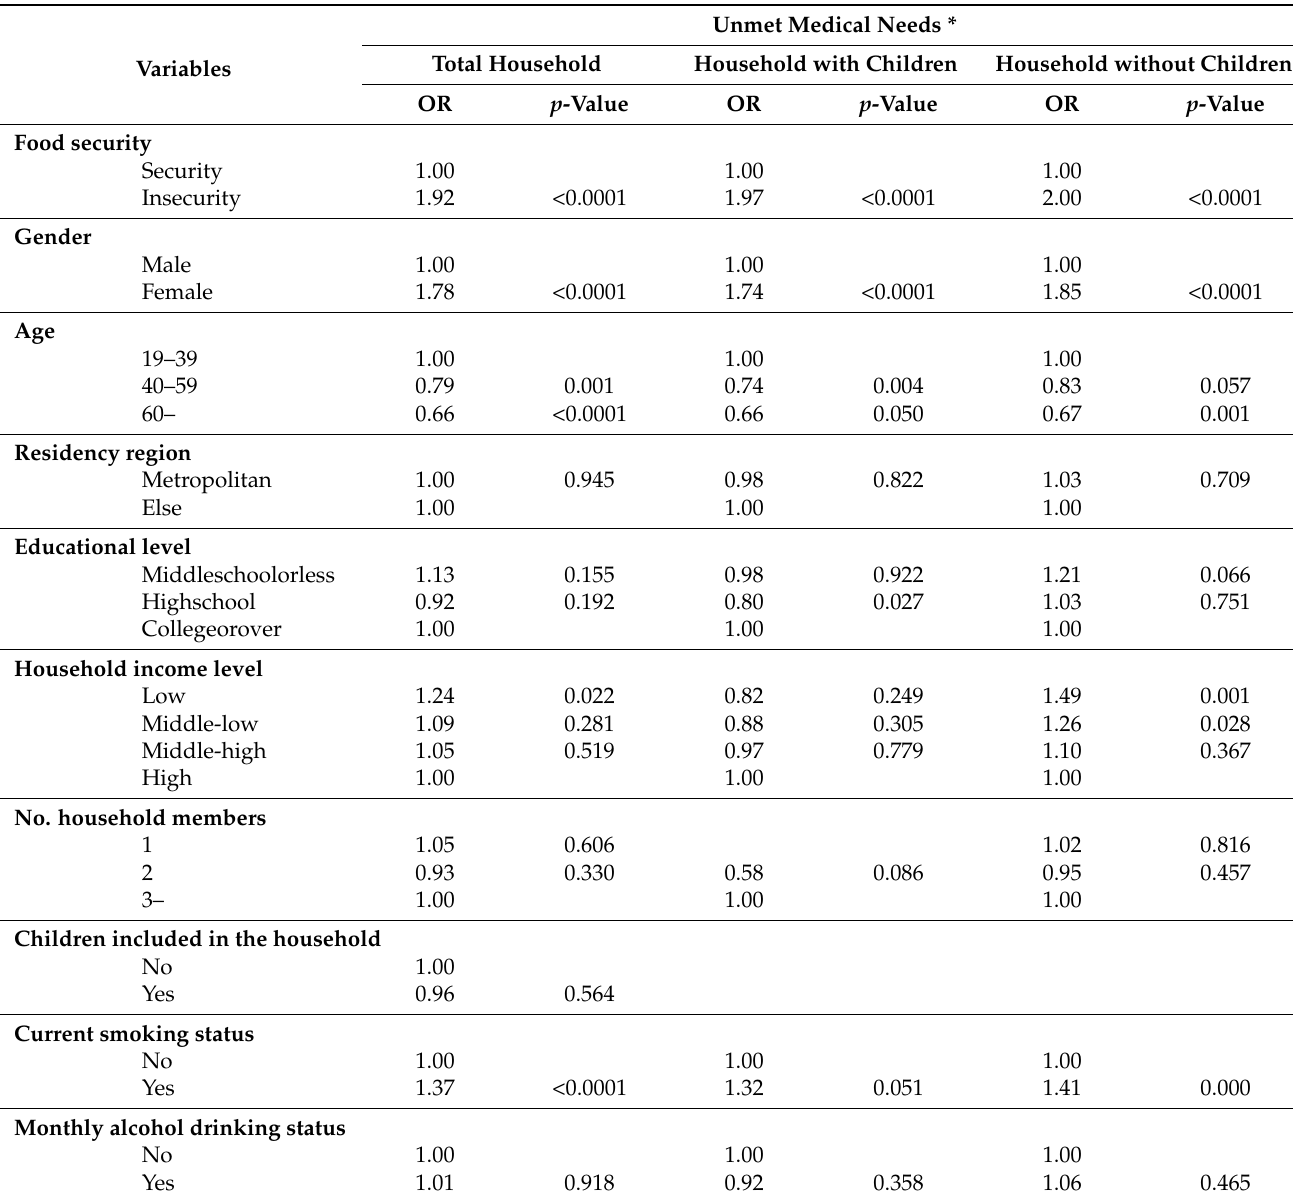
Table 2. Adjusted effect of food stability and unmet medical